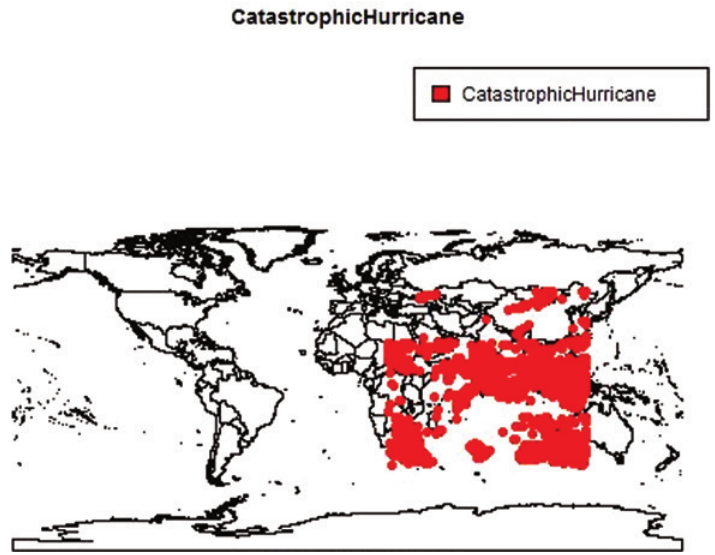
Figure 20: Q4 Results.